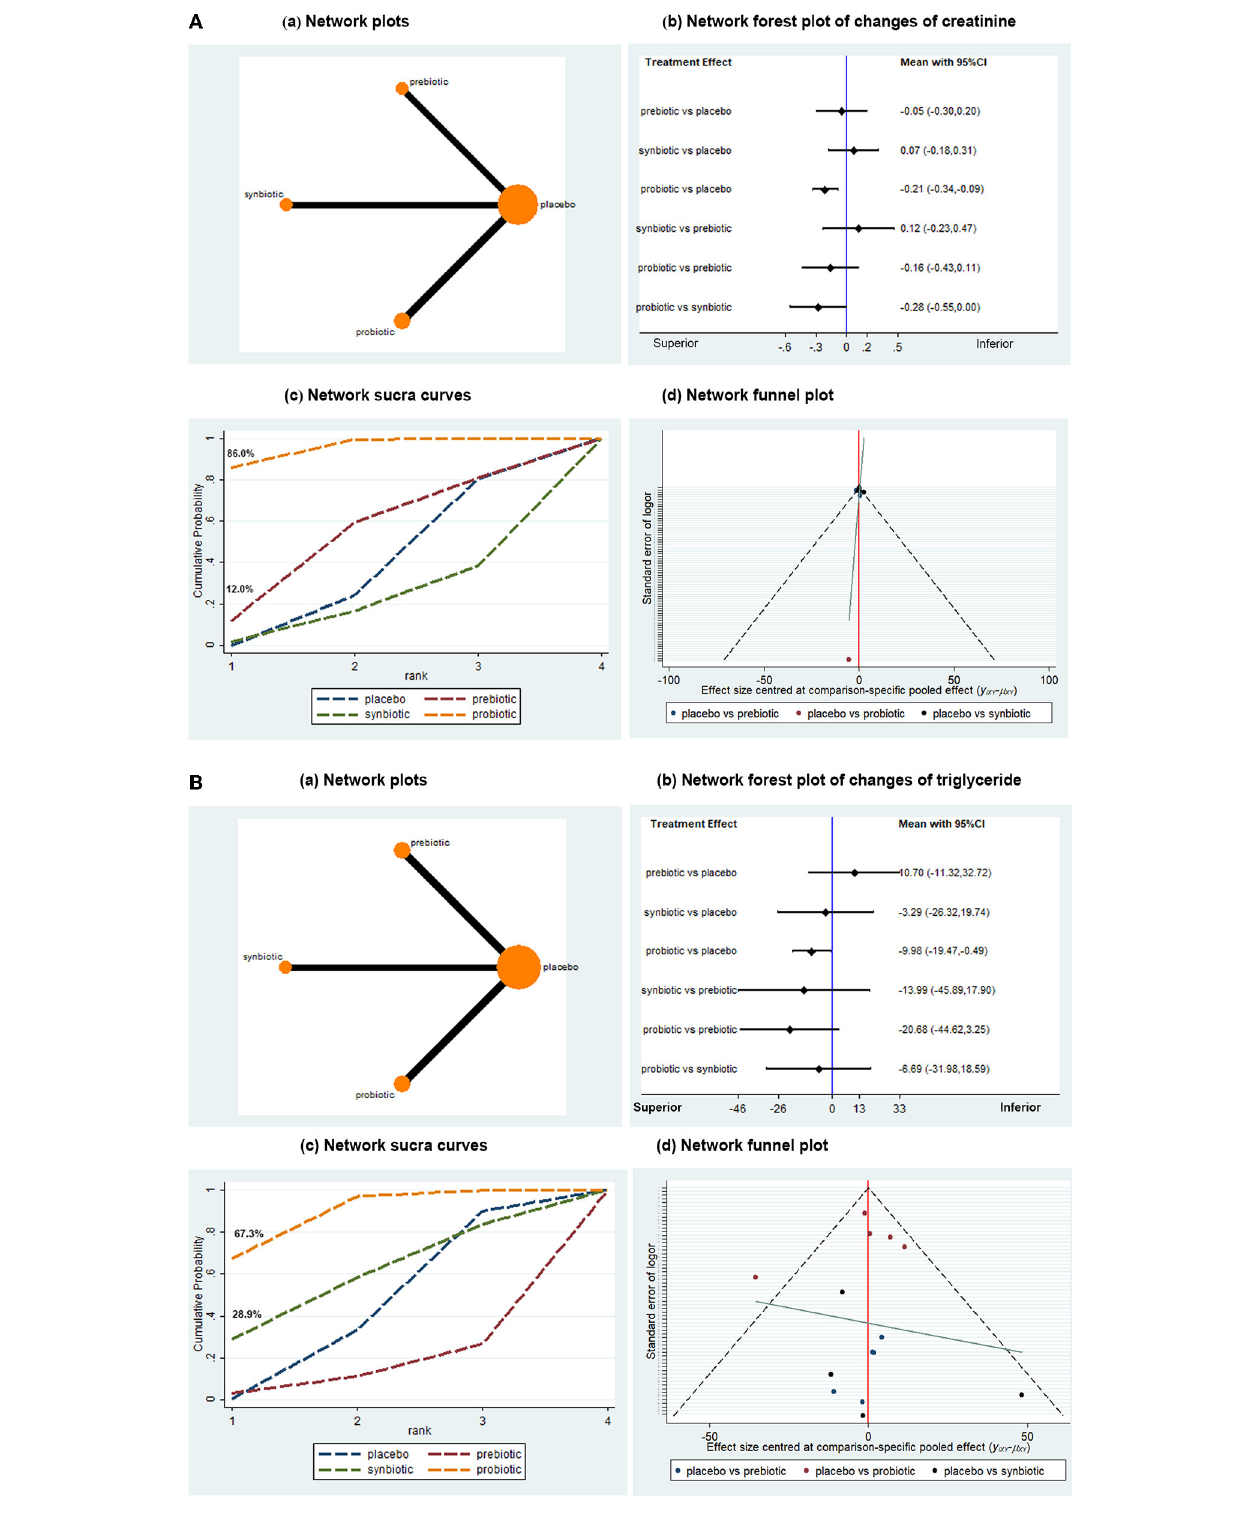
FIGURE 2 | Network meta-analysis results for the effects of probiotic, prebiotic, and synbiotic supplementation on creatinine (A) and triglyceride (B) levels.